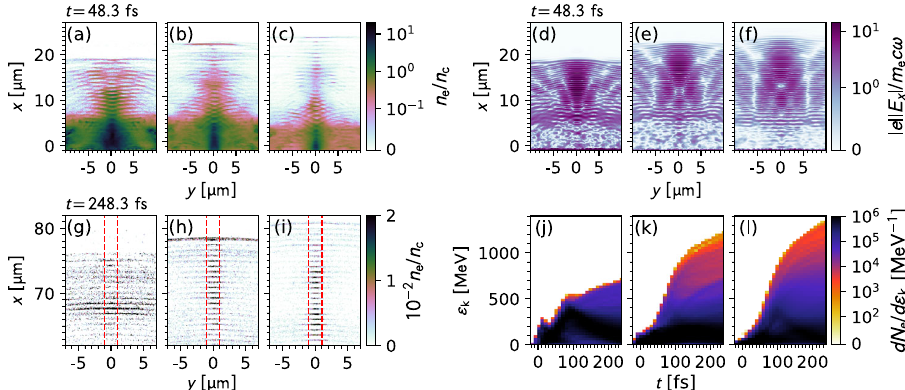
Fig. 2 Target density scan for a circularly-polarized helical beam. a – c Electron density n e normalized to the critical density n c for three different target densities ( n max ¼ 2 : 5 n c , 1.0 n c , and 0.5 n c ), shortly after laser pulse transmission ( t = 48.3fs). d – f Normalized amplitude of the longitudinal electric fi eld, ∣ e ∣∣ E x ∣ / c ω , for the same three target densities also at t = 48.3fs. g – i Density of accelerated electrons for the same three target densities at t = 248.3fs. j – l Time m e evolution of the energy distribution for forward-moving electrons selected using the same criterion as that used for Fig. 1c, with ε k = ( γ − 1) m e c 2 . In panels ( a – i ), the quantities are shown in the ( x , y )-plane at z = 0. Panels ( a ), ( d ), ( g ), and ( j ) correspond to a target with n max ¼ 2 : 5 n c ; panels ( b ), ( e ), ( h ), and ( k ) correspond to a target with n max ¼ n c ; panels ( c ), ( f ), ( i ), and ( l ) correspond to a target with n max ¼ 0 : 5 n c